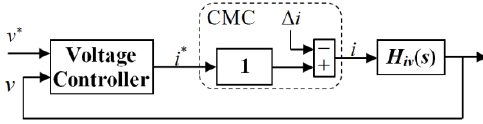
Figure 10. Current tracking in case of current mode control (CMC).